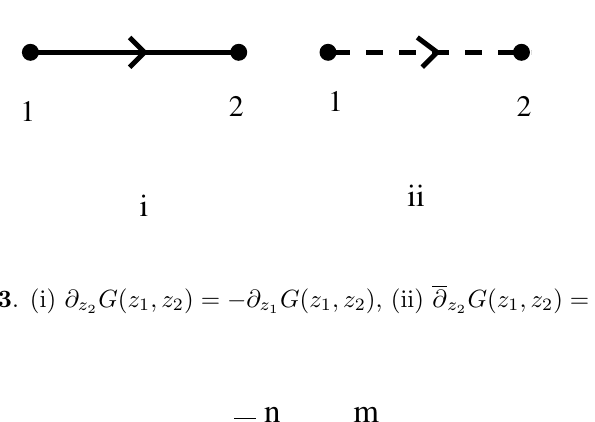
G ( z 1 ; z 2 ) = (cid:0) @ z 2